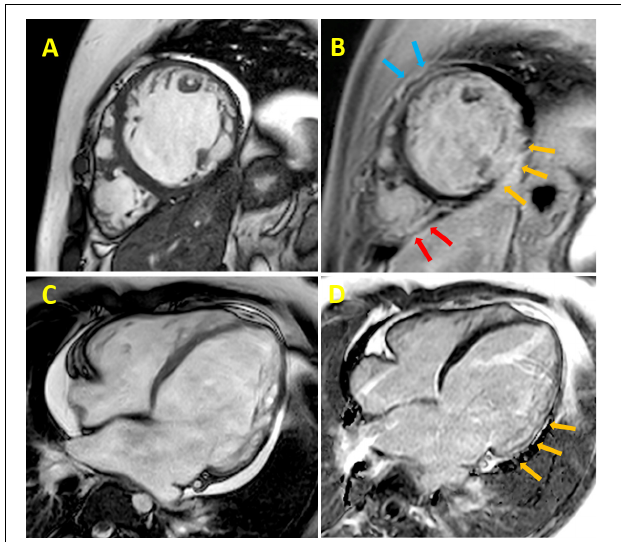
FIGURE 1 | Cardiac magnetic resonance (CMR) cine imaging of a 24 years old DMD patient. The collection of representative images from patients was approved by the Ethical Committee of the Meyer Pediatric Hospital of Florence in the context of a project funded by Telethon Italy (grant GGP16191). Informed consent to patients was performed conform the declaration of Helsinki. This data does not contribute to any novel finding. (A) Late gadolinium-enhancement (B) left ventricular (LV) short-axis section images of a patient with Duchenne muscular dystrophy (DMD). Yellow arrows indicate the inferolateral subepicardial and midwall contiguous fibrosis; light blue arrows indicate the anterior segment and the red arrows the posterolateral right ventricle wall, both showing midwall fibrosis; CMR cine imaging (C) and late gadolinium-enhancement (D) LV long-axis section images of the same patient with DMD; yellow arrows indicate midwall fibrosis of the inferolateral